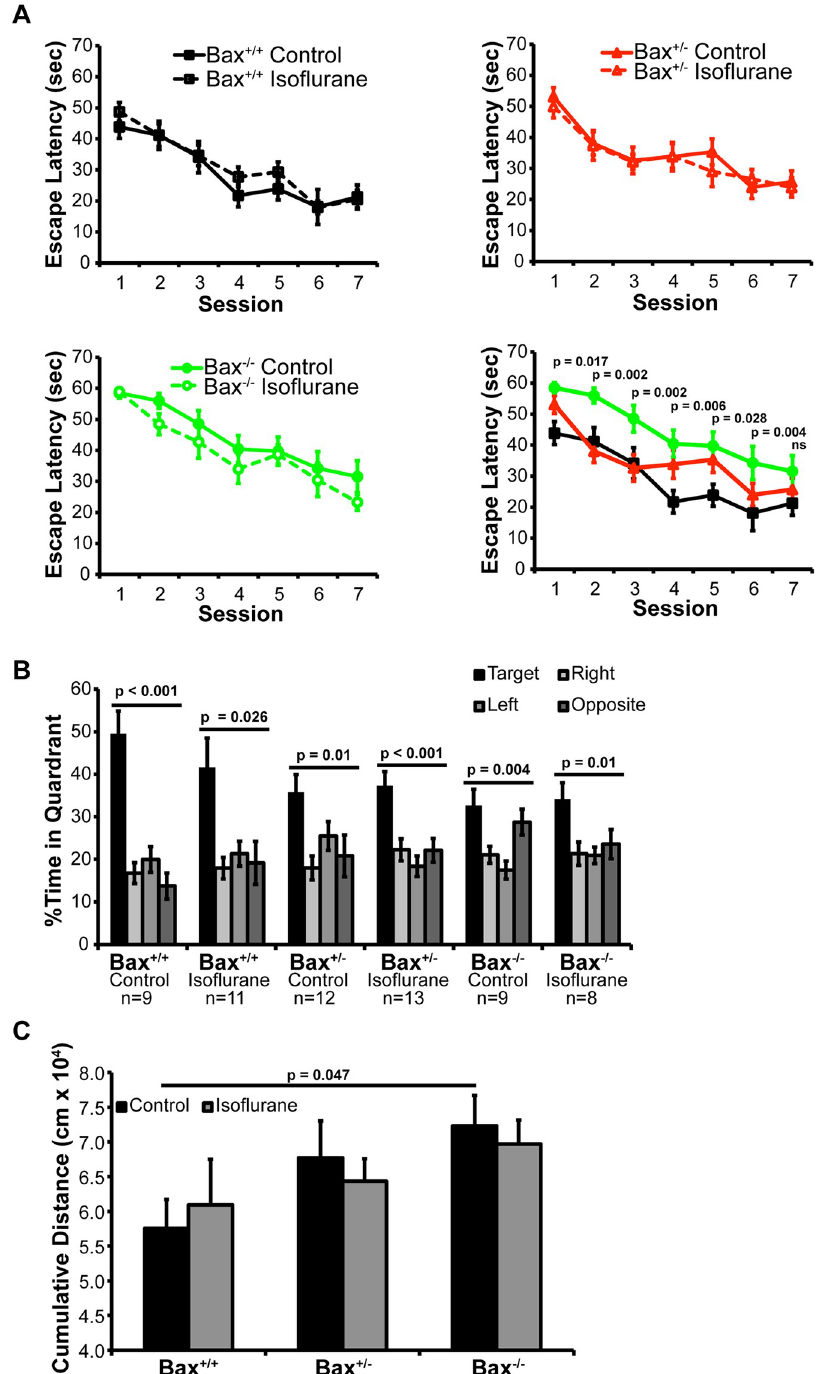
Fig 5. Hippocampal-dependent visual spatial memory formation was assessed using the Morris-Water Maze. A) Learning curves on repeated training sessions, p values comparing Bax +/+ and Bax -/- animals by group sizes are as indicated in (B). Comparison between the Bax +/+ and Bax -/- groups that were significant are indicated. B) Place preference assessed as percent time spent in each quadrant of the maze over the 60 seconds of the probe trial in which the escape platform was removed and the visual cues remained unchanged. C) Cumulative distance the animal swam from where the platform was originally located.